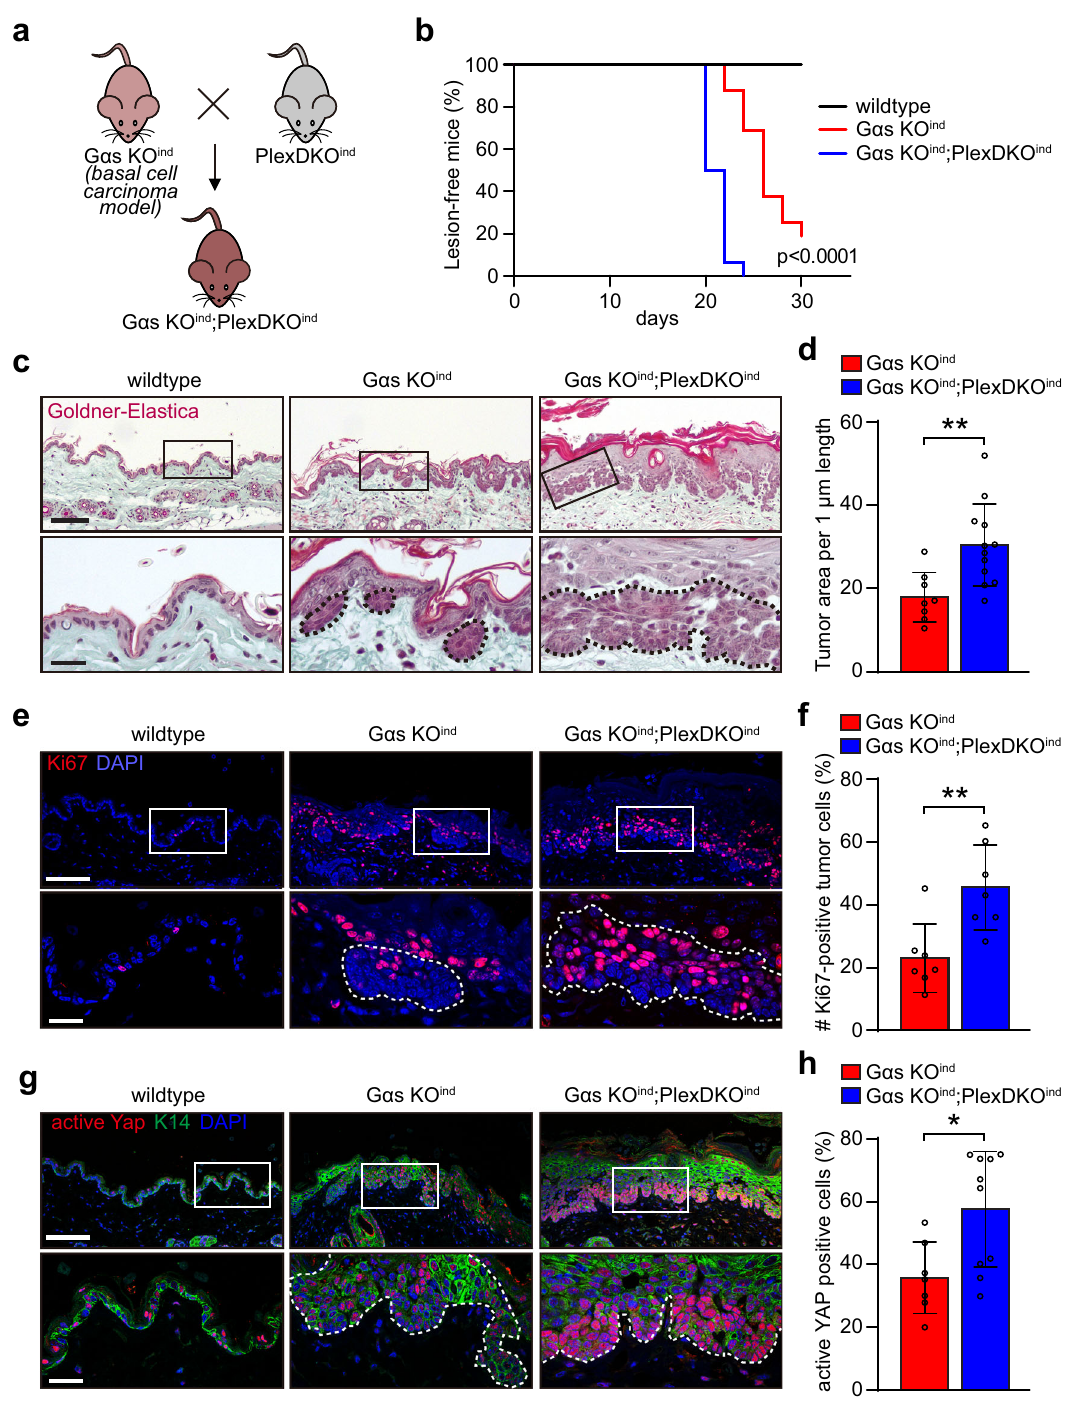
Fig. 6 Plexin-B1/Plexin-B2 control YAP activity and cell proliferation in basal cell carcinoma. a Schematic illustration of the generation of epidermis- speci fi c tamoxifen-inducible G α s /Plexin-B1/Plexin-B2 triple-de fi cient mice. b Kaplan – Meier curves representing the percentage of lesion-free mice. Time point “ 0 ” indicates the start of tamoxifen treatment (wildtype mice: n = 3, G α s KO ind mice: n = 16, G α s KO ind ;PlexDKO ind mice: n = 16; p < 0.0001; Mantel – Cox test for G α s KO ind compared to G α s KO ind ;PlexDKO ind ). c – h Histological/immuno fl uorescence stainings (left panels) and respective quanti fi cations (right panels) of adult murine skin of mice with the indicated genotypes 30 days after treatment with tamoxifen. Boxed areas are magni fi ed in the lower rows. Tumors are marked by dashed lines. c Goldner-Elastica stain of histological sections. Scale bar, 100 µ m (upper row), 25 µ m (lower row). d Quanti fi cation of tumor areas (mean ± s.d.; G α s KO ind mice: n = 8, G α s KO i n d ;PlexDKO ind mice: n = 12; p = 0.0049; two-sided unpaired t -test). e Confocal images of immunostainings using an anti-Ki67 antibody (red). Scale bar, 100 µ m (upper row), 25 µ m (lower row). f Quanti fi cation of Ki67- positive cells (mean ± s.d.; G α s KO ind mice: n = 7, G α s KO i n d ;PlexDKO ind mice: n = 7; p = 0.0049; two-sided unpaired t -test). g Confocal images of immunostainings using anti-active YAP (red) and anti-K14 antibodies (green). Scale bar, 100 µ m (upper row), 25 µ m (lower row). h Quanti fi cation of cells positive for active YAP (mean ± s.d.; G α s KO ind mice: n = 7, G α s KO i n d ;PlexDKO ind mice: n = 10; p = 0.0143; two-sided unpaired t